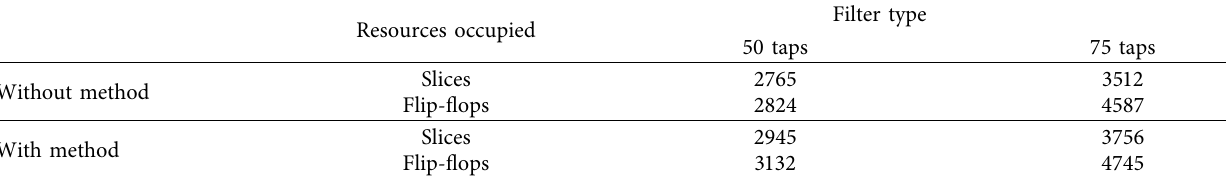
Figure 8: Example of simulation results. Table 6: Resource design results.